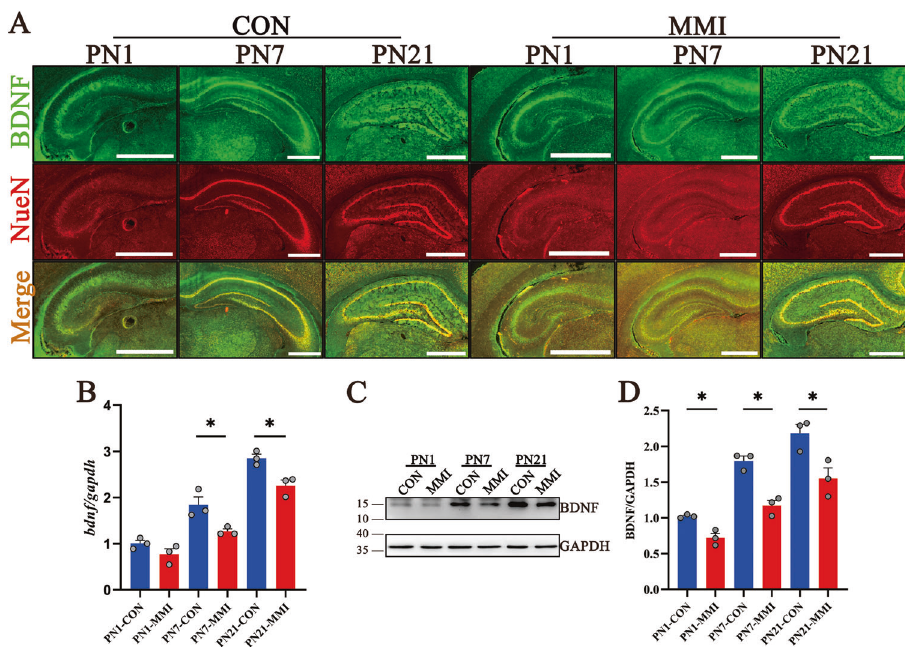
of rat pups by RT-PCR and western blot. Experiments were performed in triplicates. Error bars represent the standard error (* P < 0.05).